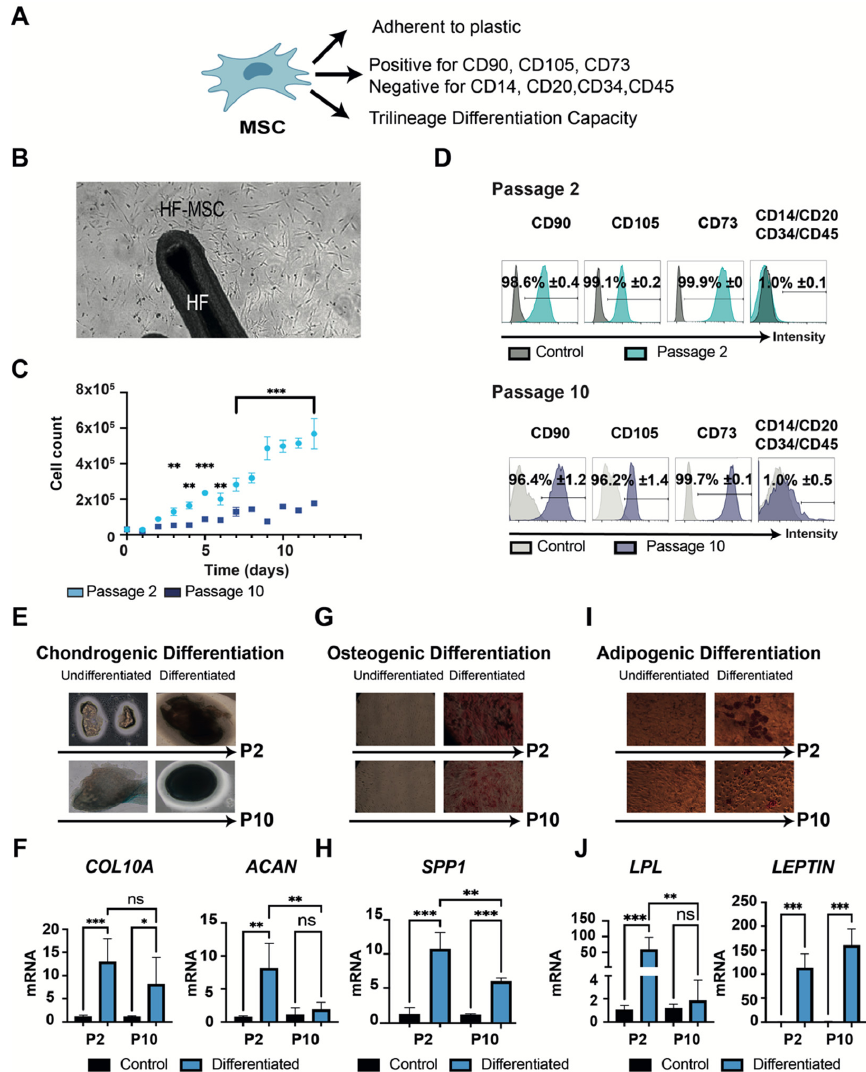
Figure 2. Characterization of minimal criteria to define MSCs. ( A ) A schematic representation of the MSCs and their necessary properties. ( B ) Microscopic image representing the capacity of the HF-MSCs to adhere to plastic at 10 × amplification. ( C ) Graphical representation of the proliferation potential of HF-MSCs at both passage 2 and passage 10. ( D ) Cells cultured at passage 2 and passage 10 were harvested and labelled with antibodies against the following cell surface proteins: CD90, CD105, CD73, CD14, CD20, CD34, and CD45. Flow cytometry histograms of cells at P2 (teal) and P10 (dark blue) are shown. Gray histograms indicate isotype control for each antibody. Each datapoint represents the mean for three wells ± SD. ( E – J ) Trilineage differentiation of cells at both passage 2 and passage 10. ( E ) Chondrogenic differentiation capacity of HF-MSC after 21 days with the differentiation medium. Blue color represents the secretion of sulfated proteoglycans visualized with Alcian blue at 10 × amplification. ( F ) Chondrogenic differentiation was further confirmed by COL10A and ACAN gene expression. ( G ) Osteogenic differentiation capacity of HF-MSCs. Deposition of calcified nodules was visualized by Alizarin Red staining at 10 × amplification. ( H ) Osteogenic differentiation was further confirmed by SPP1 gene expression. ( I ) Adipogenic differentiation capacity of HF-MSCs. Red color indicates the staining of lipid vesicle-forming adipocytes by Oil Red staining at 20 × amplification. ( J ) Adipogenic differentiation was further confirmed by LPL and LEPTIN gene expression. Each datapoint represents the mean for at least three wells ± SD. Statistical significance: *** p < 0.001, ** p < 0.01, * p < 0.05, ns, no significant difference p > 0.05. MSC, mesenchymal stromal cells. P2, passage 2. P10, passage 10. HF-MSC, hair follicle-derived mesenchymal stromal